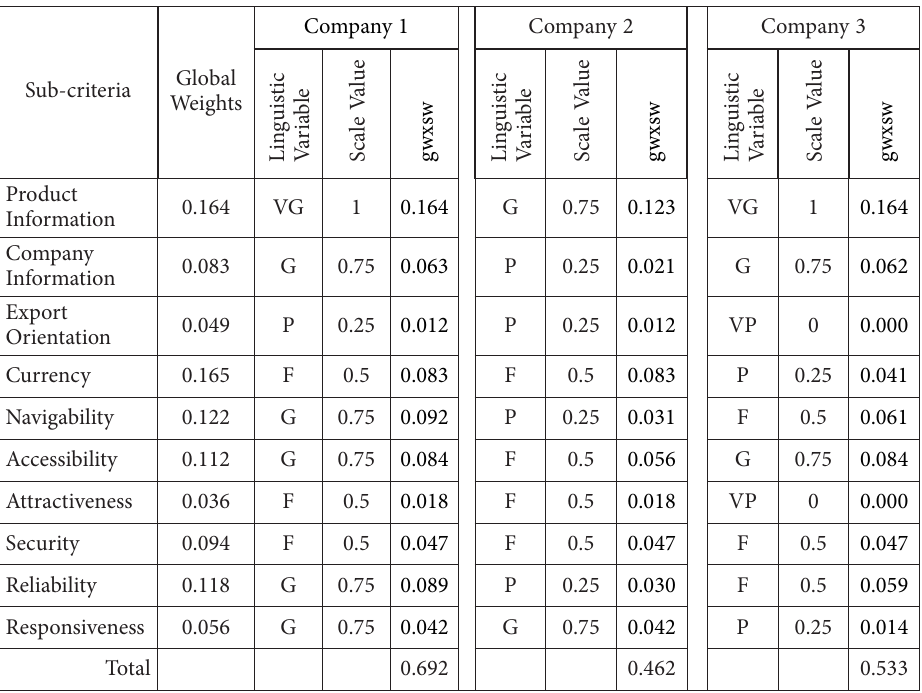
Table 6. Ranking of alternative